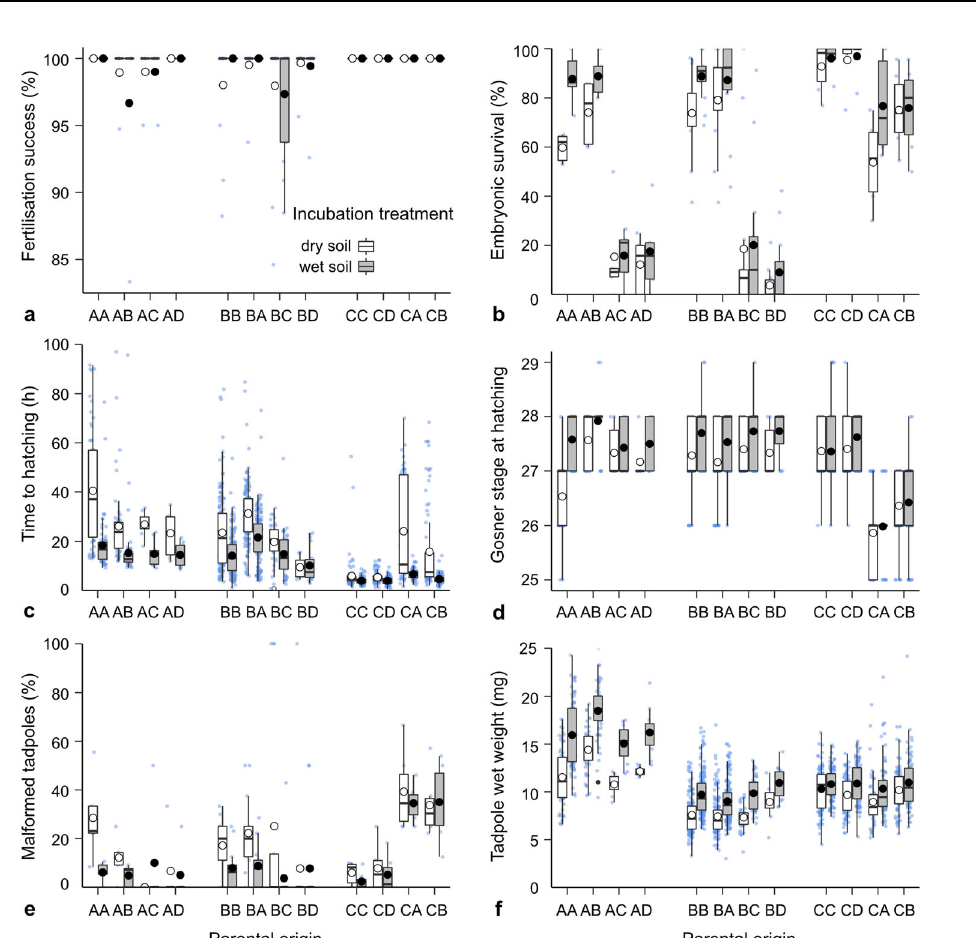
Fig. 2 Fertilisation success and embryonic and hatchling trait responses to dry and wet rearing environments in within- and between-population crosses of four populations. Fertilisation success was measured for 92 population crosses ( a ) and traits were measured for between 1460 and 2793 embryos and tadpoles ( b – f , see Supplementary Table 1). The fi rst letter of the parental origin represents the female (population) origin, and the second letter represents the male origin. Mean responses (large white or black circles, according to treatment) are superimposed over boxplots, which are superimposed over raw data (jittered small blue circles). Lower and upper boxplot boundaries are 25th and 75th percentiles, respectively, the thicker line inside the box is the median value, and lower and upper error bars are 10th and 90th percentile,